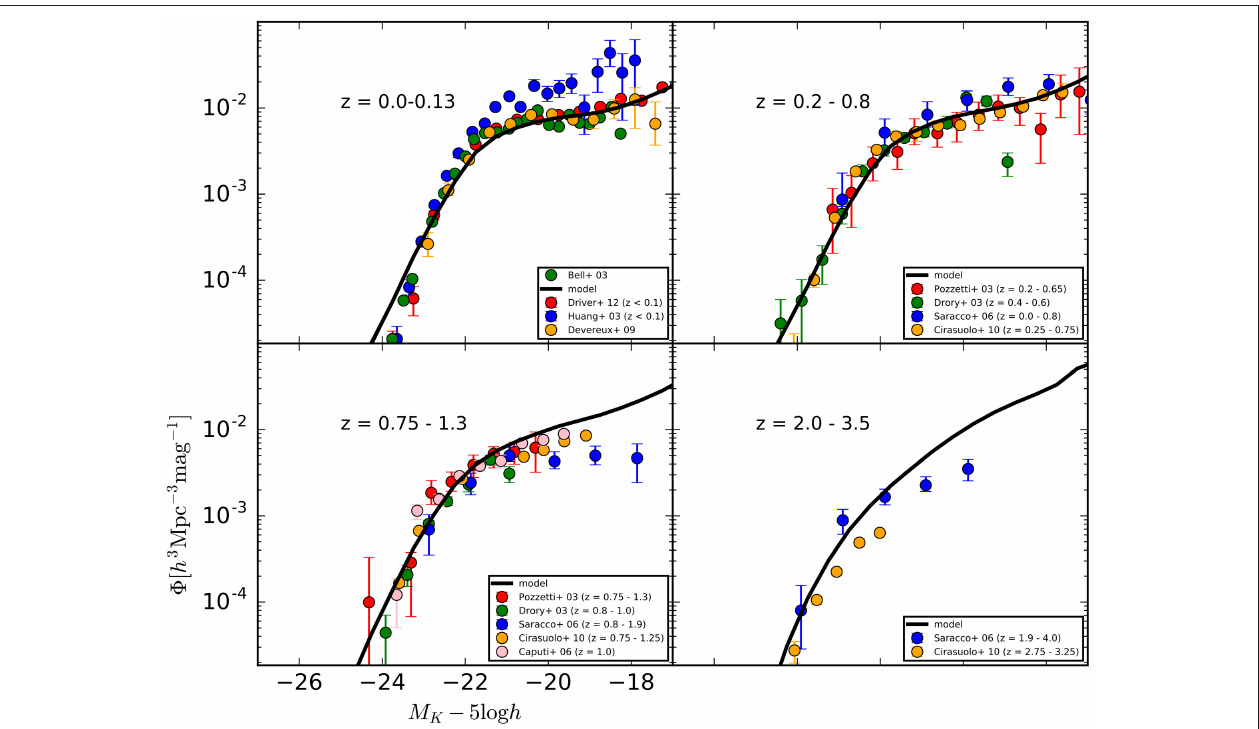
FIGURE 1 | K -band luminosity functions of galaxies from z = 3.5 to 0. The model results are shown in black lines. Dots describe observational results obtained from Bell et al. (2003); Driver et al. (2012); Huang et al. (2003); Devereux et al. (2009); Pozzetti et al. (2003); Drory et al. (2003); Saracco et al. (2006); Cirasuolo et al. (2010); Caputi et al. (2006) (see labels in this